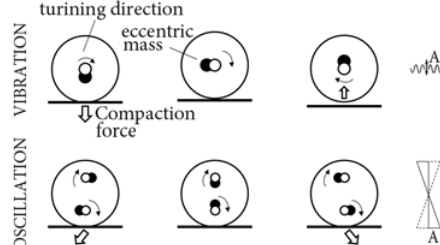
fig. 1. Vibration and oscillation principles – adapted from Mooney et al. (2010) and Kearney (2006)